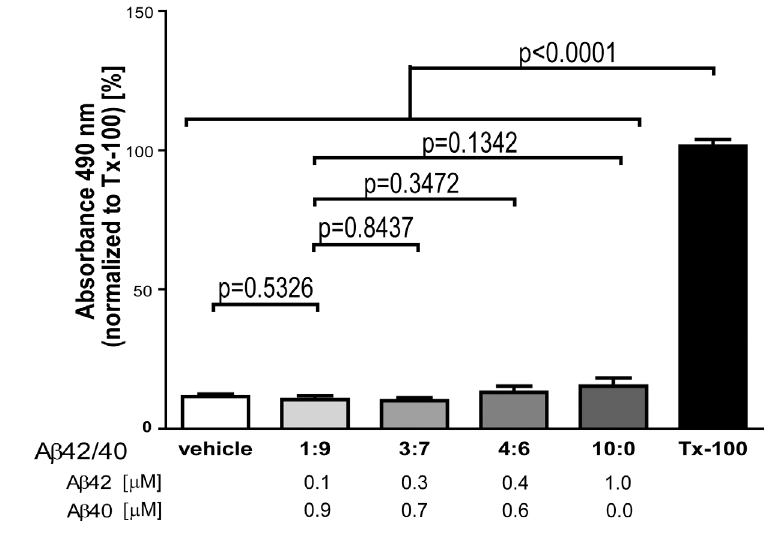
Figure 3. Cytotoxicity of A β treatment. Relative levels of the lactate dehydrogenase (LDH) activity in the conditioned medium after A β treatments. 1% Tx-100 is used as a positive control. n = 21 (vehicle), n = 18 (1:9), n = 15 (3:7), n = 18 (4:6), n = 17 (10:0), n = 18 (Tx-100), mean ± SEM, two-tailed unpaired Student t test. A β – amyloid β , Tx-100 – Triton